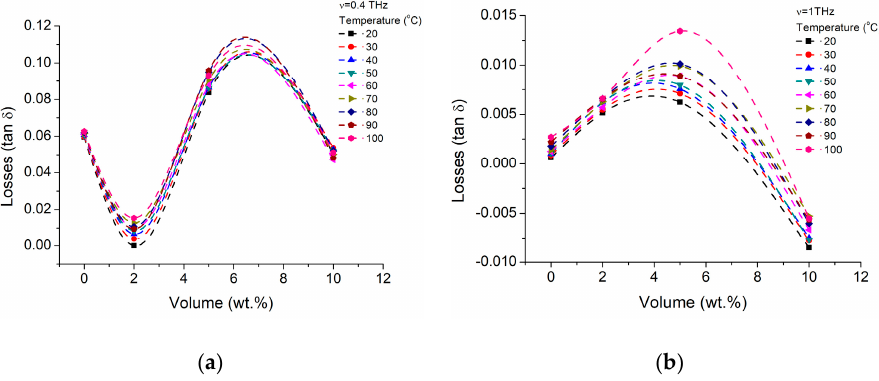
Figure 17. BTO-SBS losses variation with BTO nanoparticles volume fraction for two working frequencies of ( a ) 400 GHz and ( b ) 1 THz, at different working temperatures.